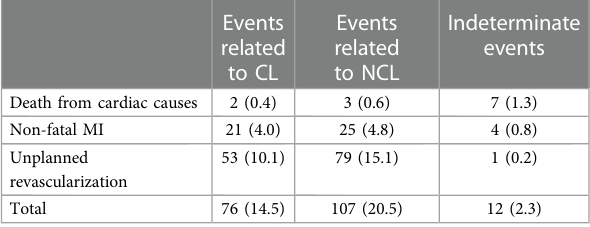
TABLE 2 Study endpoints related to CL, NCL, or indeterminate